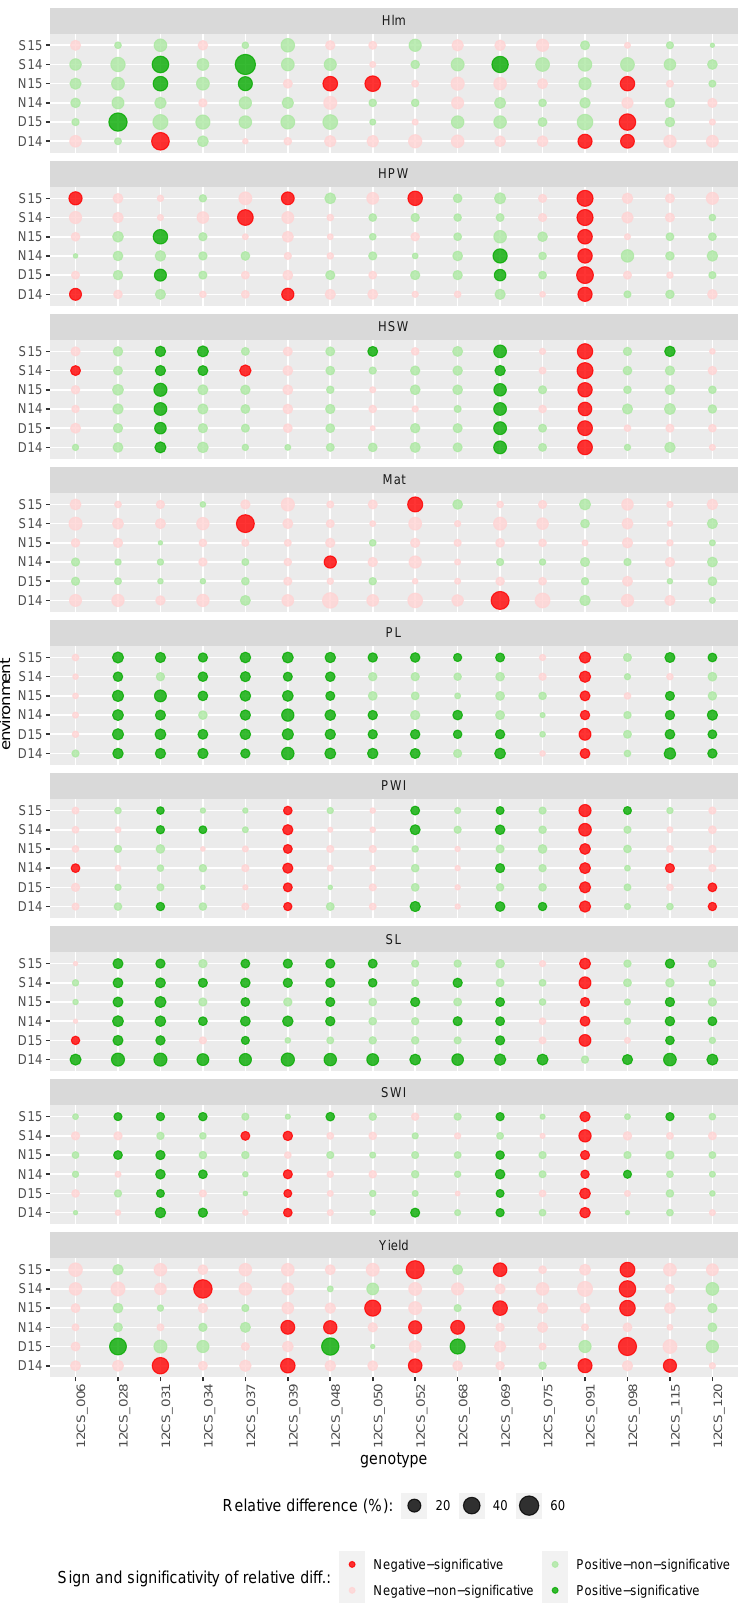
Figure 2. Relative di ff erence between the CSSLs and Fleur11 for all traits across the six environments. Hlm (haulm yield); HPW (100 pod weight); HSW (100 seed weight); Mat (percentage of pod maturity); PL (pod length); SL (seed length); PWI (pod width); SWI (seed width); Yield (pod